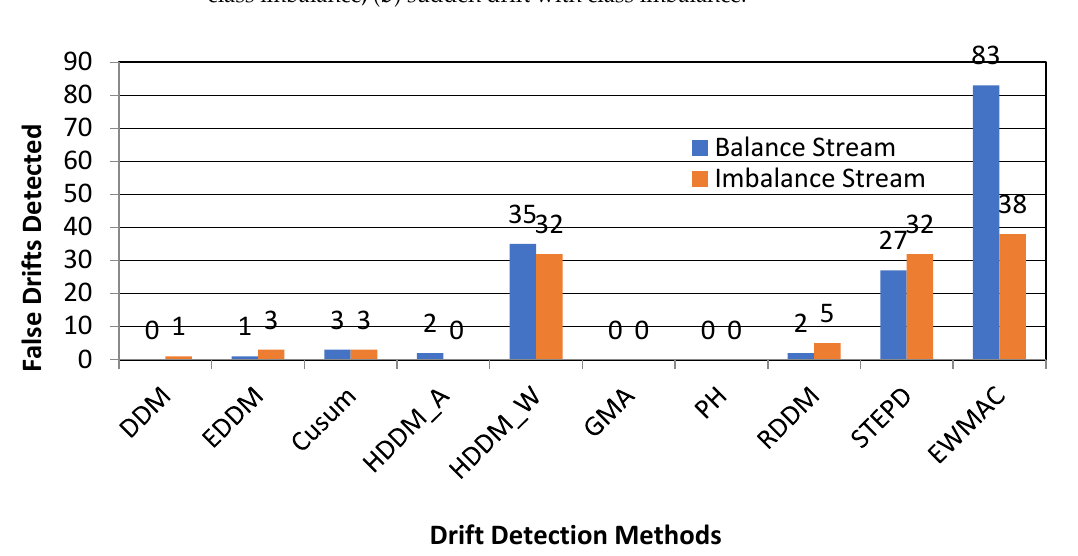
Figure 4. Effect of drift detection methods on base classifier’s performance: ( a ) sudden drift without class imbalance; ( b ) sudden drift with class imbalance.